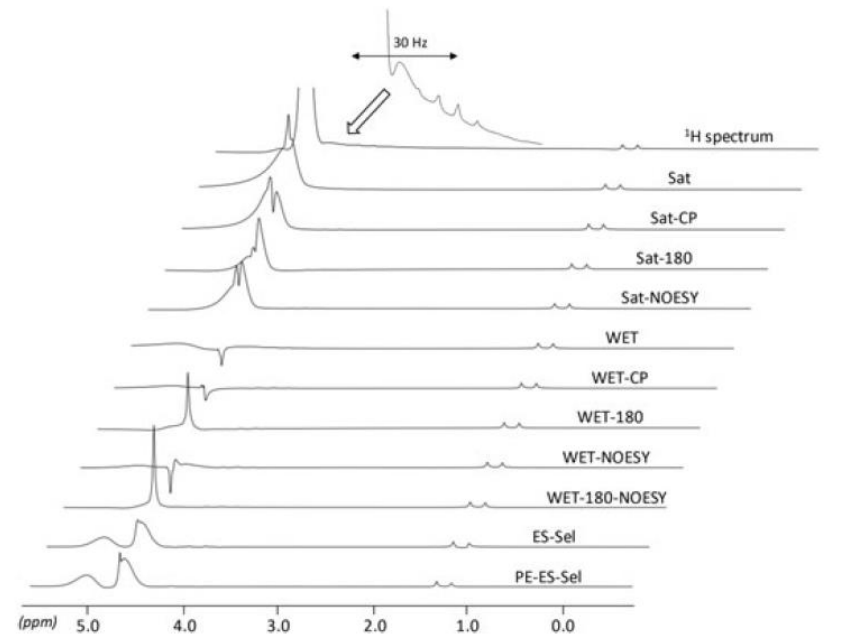
Figure 9. Application of several pulse sequences for water signal suppression in 0.2 M aqueous lactate. The same receiver gain and vertical scale were used in all cases. Abbreviated pulse sequences: Sat (Saturation), CP (Cross-polarization), NOESY (Nuclear Overhauser Enhancement Spectroscopy), WET (Water suppression Enhanced through T1 effects), ES (Echo subtraction), Sel (Selective pulses), and PE (Phase encoding). Adapted with permission from [97], Wiley, 2017.